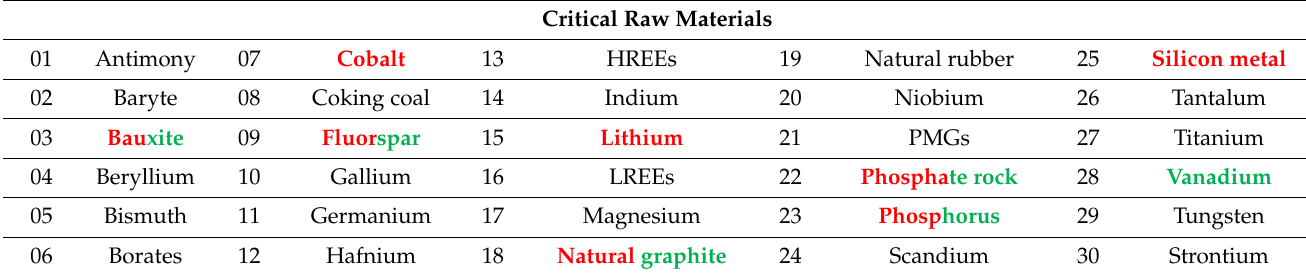
Table 3. Thirty identified critical raw materials from the list by the EU Commission—highlighted are materials used in different lithium batteries (red) and flow batteries